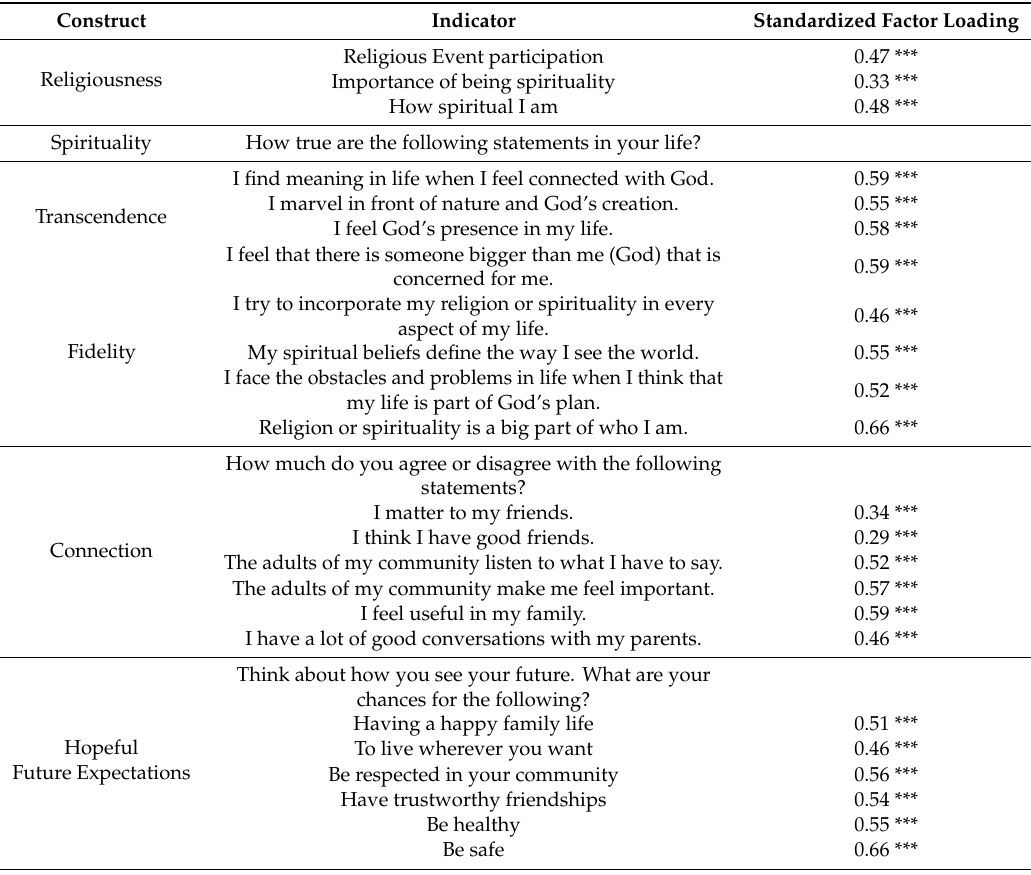
Table 1. Standardized factor loadings for indicators with latent constructs in confirmatory factor analysis